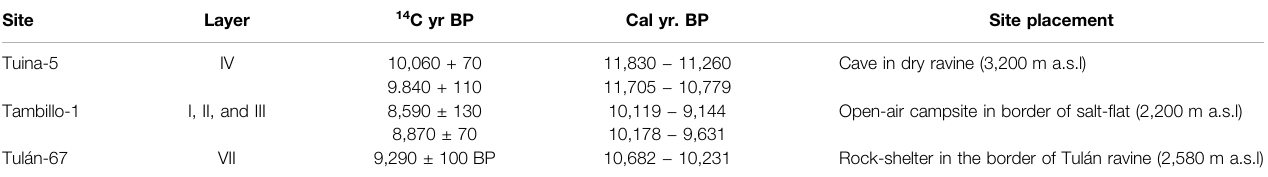
TABLE 1 | Lithic assemblages studied, by archaeological site, stratigraphic layer, chronology and placement (after Núñez et al., 2005). Radiocarbon dates were calibrated using the ShCal020 curve (Hoggs et al., 2020) in OxCal software. Site